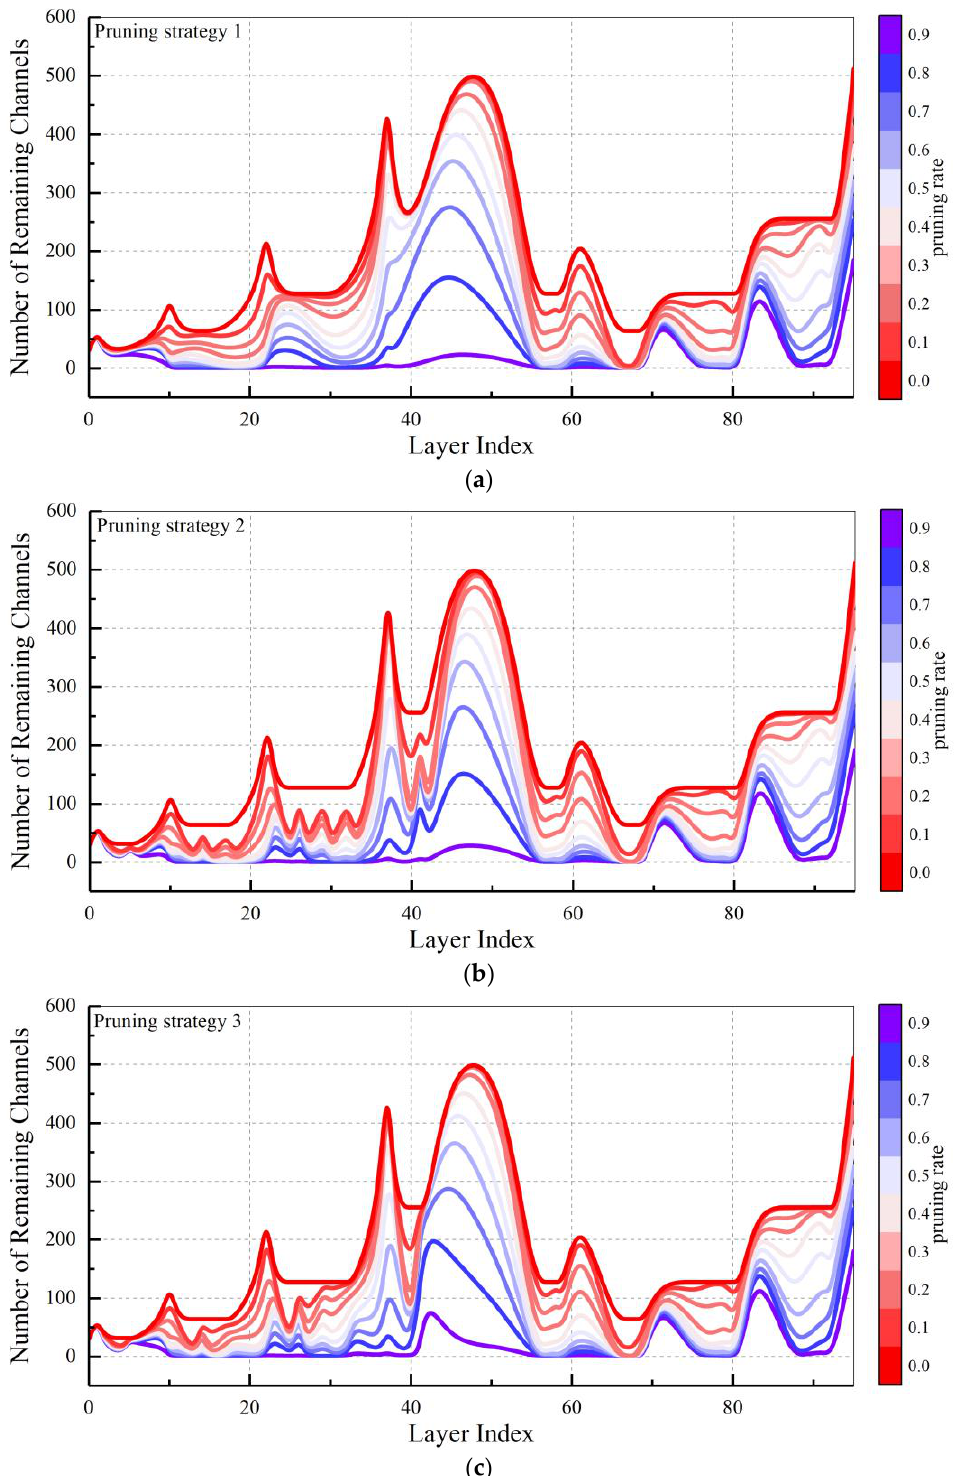
Figure 5. Effects of different pruning ratios and methods on the number of remaining channels ( a ) Result of pruning strategy 1. ( b ) Result of pruning strategy 2. ( c ) Result of pruning strategy 3.